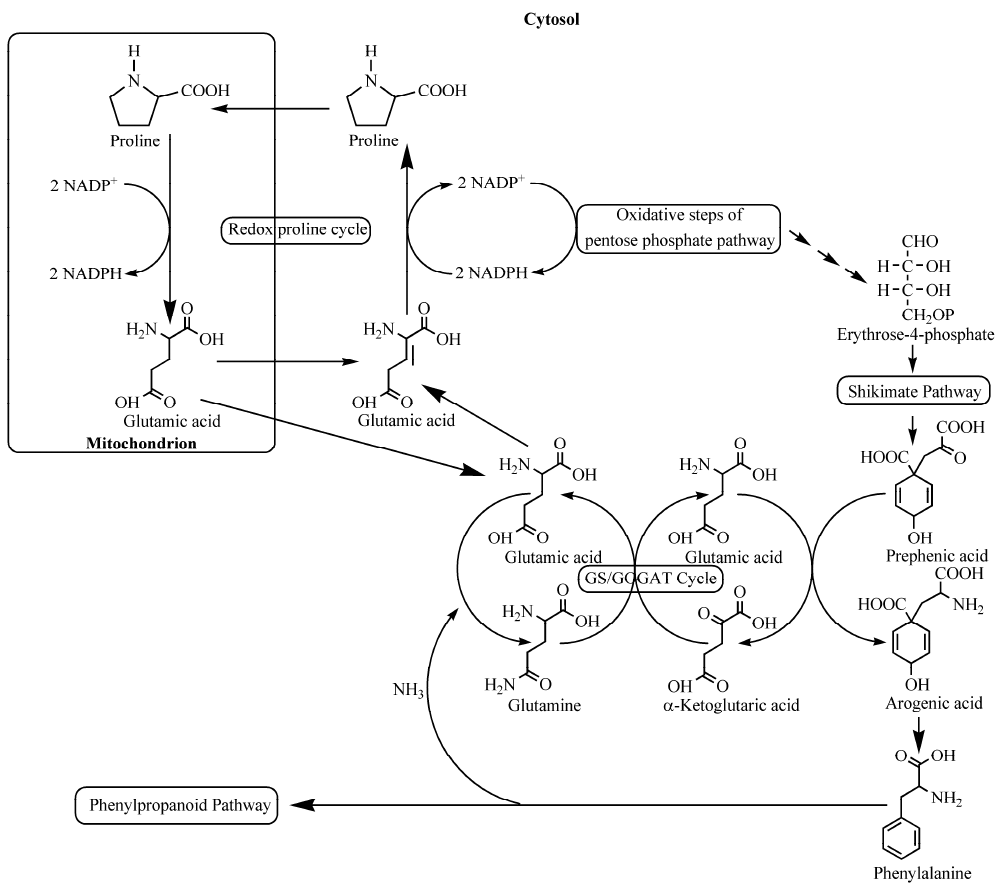
Figure 2. Relationships between primary and secondary metabolism and role of endogenous proline in stimulating phenylpropanoid pathway. GS, glutamine synthetase; GOGAT, glutamate synthase (redrawn from [115] with permission of Elsevier).